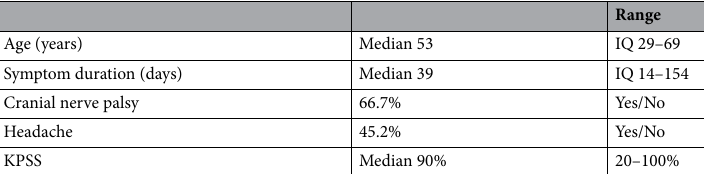
Table 1. Patient demographics including median age, median symptom duration, percentage of patients suffering from preoperative cranial nerve palsy and headache, and median Karnofsky Performance Status Scale